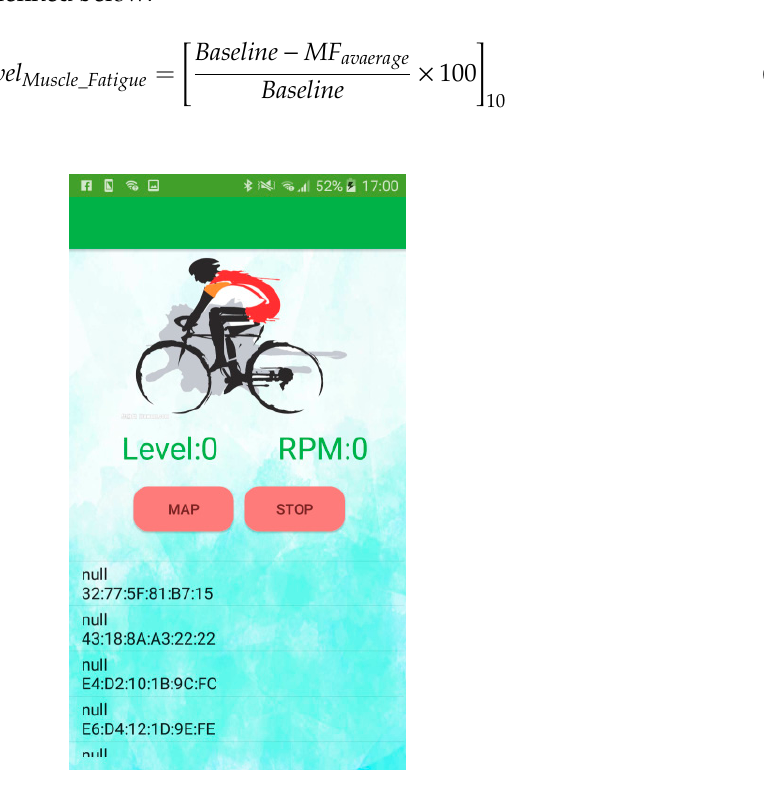
Figure 8. APP screen snapshot.